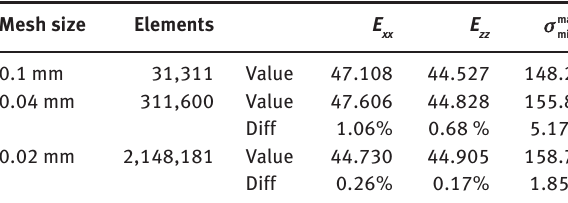
Table 4: Convergence study for mesh size. Mesh size